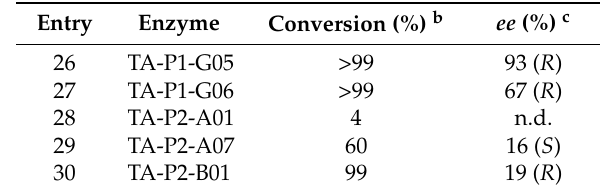
Table 2. Biotransamination of ketone 6 using Enzymicals AG ATAs. a